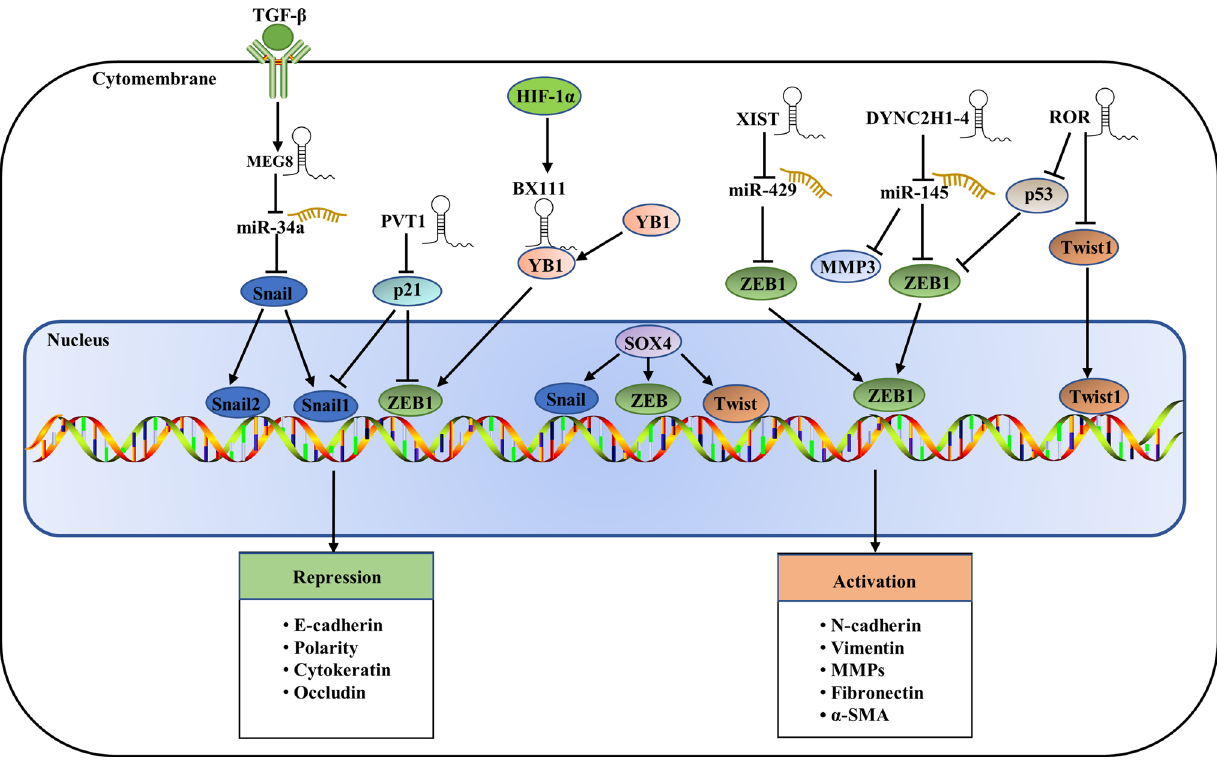
Fig. 1 Roles and regulation of major EMT transcription factors. Epithelial mesenchymal transition is driven by Snail, ZEB and Twist transcrip- tion factors, and lncRNAs mainly act as sponges for miRNAs to regulate the expression of transcription